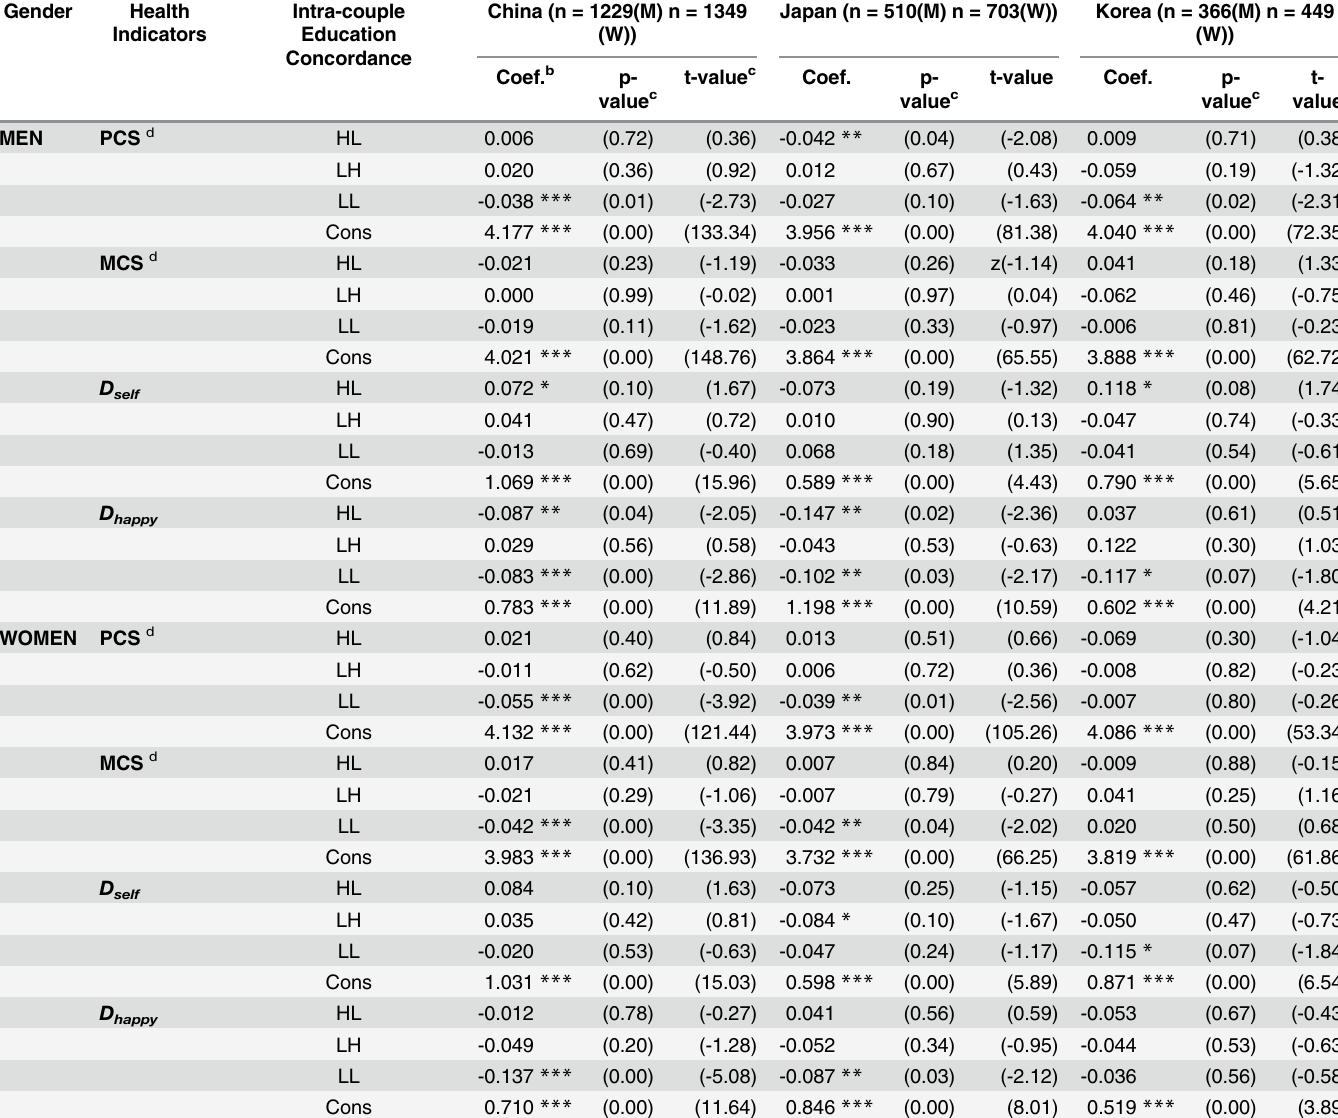
Table 4. Education Concordance Effect by Gender and Country a .